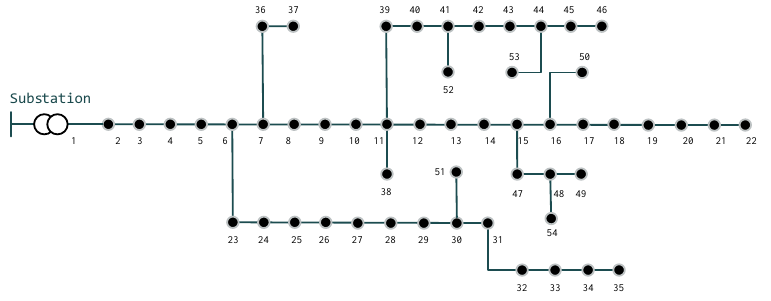
Figure 9. The single line diagram of the Malaysian 54 bus system.